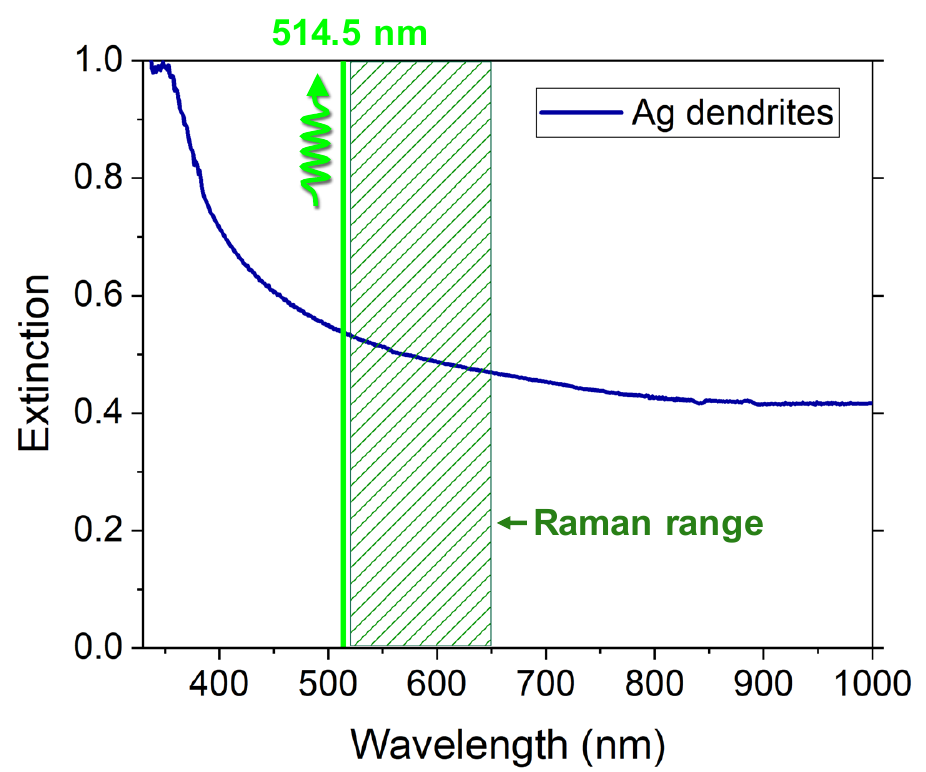
Figure 2. Extinction of the Ag dendrites in the visible NIR range. The laser wavelength used for SERS excitation at 514.5 nm and the corresponding Raman region of SARS-CoV-2 Omicron variant analyzed in this work (520–648 nm, corresponding to 200–4000 cm − 1 ), are indicated by the vertical green line and the dark green dashed box, respectively.